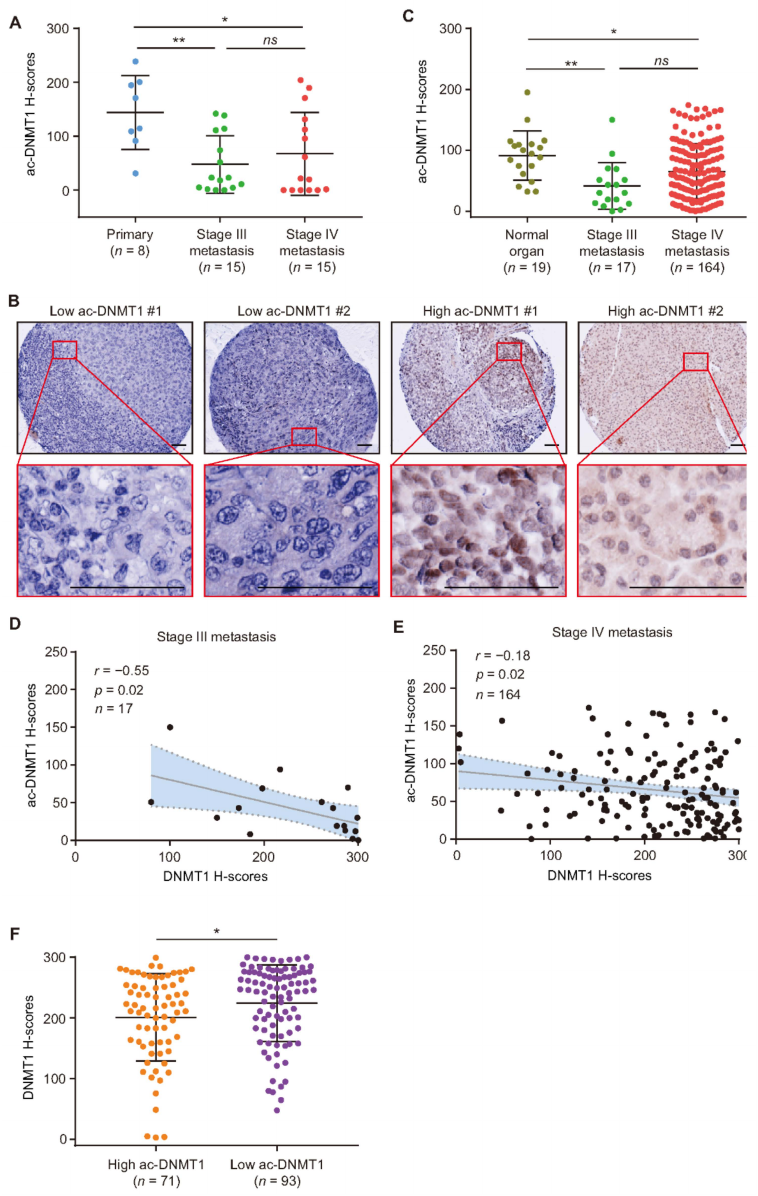
Figure 3. Decreased ac-DNMT1 protein levels are associated with melanoma progression. ( A ) Comp- arison of ac-DNMT1 H-scores in FFPE tissues from primary melanoma, stage III, and stage IV metastatic FFPE tissues. ( B , C ) Representative IHC images and H-score quantification of ac-DNMT1 in normal organ tissues, stage III, and stage IV metastasis from TMA cohort. Scale bars = 20 µ m. ( D , E ) Correlation between ac-DNMT1 and DNMT1 IHC H-scores in stage III ( D ) and stage IV ( E ) metastatic FFPE tissues. The best-fit line (straight line) and the 95% CI (dotted line) are shown in grey. ( F ) Comparison of DNMT1 H-scores in stage IV patients with high or low ac-DNMT1 levels. Data represent the mean ± SD. ns : not significant, * p < 0.05, and ** p <